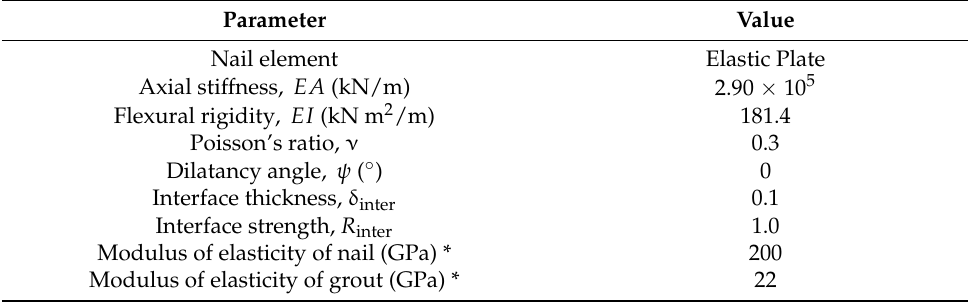
Table 2. Soil and nail parameters used for FE analysis. Parameter Value Nail element Elastic